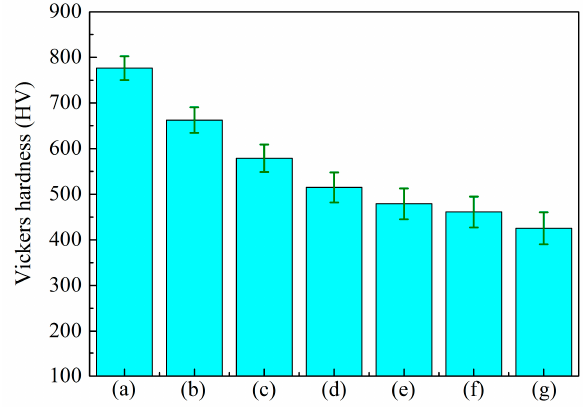
Figure 12. The hardness of the microarc oxidation coatings formed on aluminum alloys at different anode pulse-widths. (a): 1000 μ s; (b): 1500 μ s; (c): 2000 μ s; (d): 2500 μ s; (e): 3000 μ s; (f): 3500 μ s; (g): 4000 μ s.